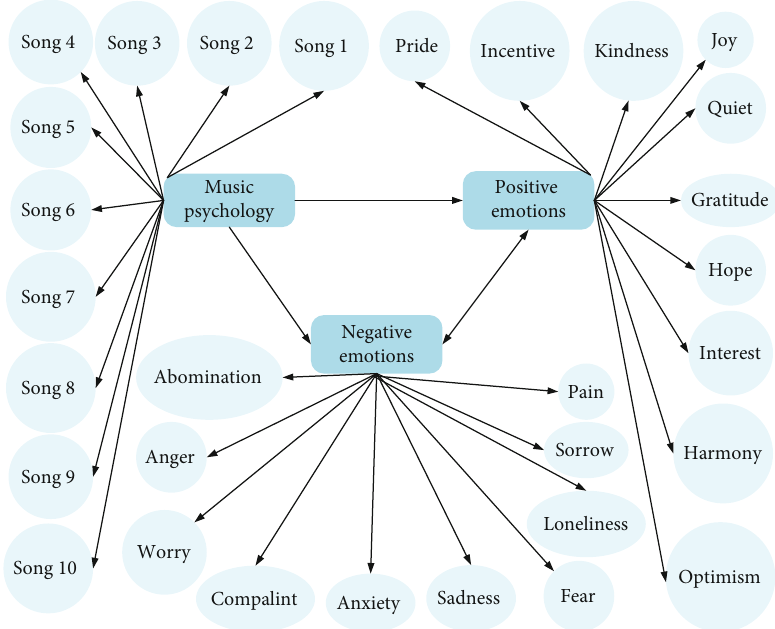
Figure 1: Structure equation prediction model